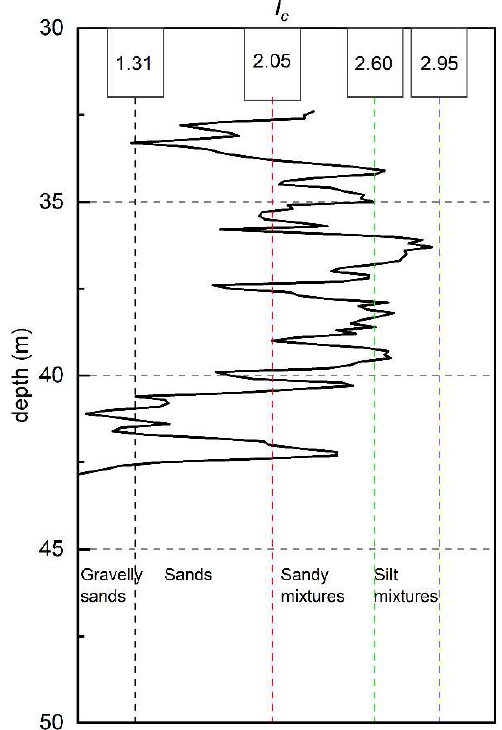
Figure 7. Soil classification of CW gneiss based on CPT data from 32.3 m to 42.9 m.